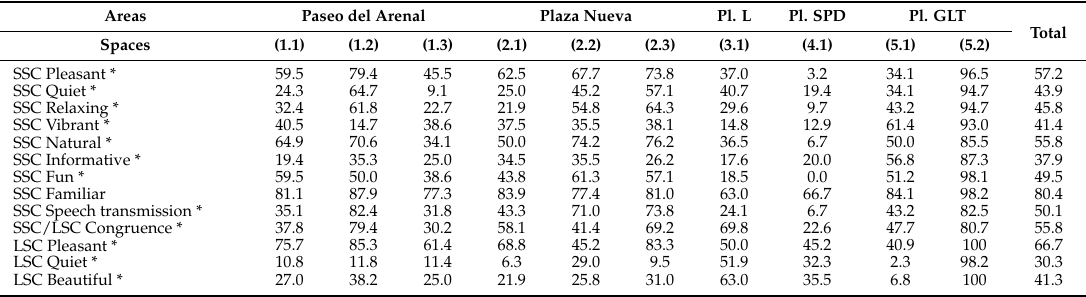
Table 4. Percentage of positive perception (scores 4 and 5 of the ordinal 5-point scale) of landscape (LSC) and soundscape (SSC) in the ten analysis areas (* p < 0.001 associated to χ 2 ). Areas Paseo del Arenal Plaza